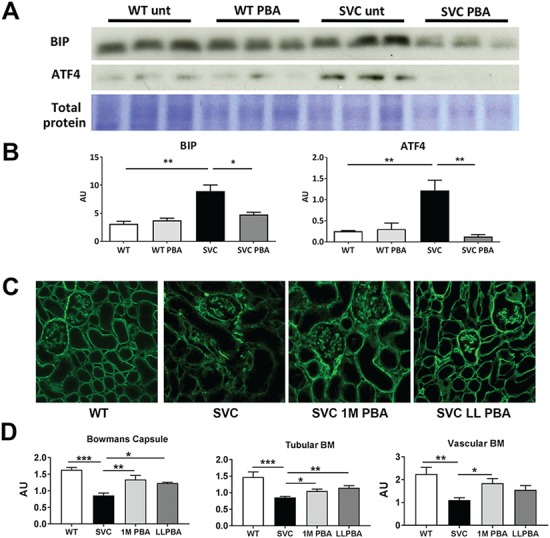
Chemical chaperone activity increases deposition of collagen IV in vivo. (A) Western blotting showed increased levels of Bip (∼2.9-fold increase) and ATF4 (∼4.6-fold increase) in untreated Col4a1+/Svc (SVC unt) which is reduced following PBA treatment. Representative band of total protein stain is given as loading control (the entire gel is provided in Supplementary Material, Fig. S9). (B) ImageJ densitometry analysis of Bip and ATF4 (n = 3). (C) Immunostaining against Col4a1 in PBA-treated and untreated Col4a1+/Svc mice (WT: wild-type; SVC: untreated; SVC 1M PBA: 1-month treatment; SVC LL PBA: lifelong chronic treatment from conception) on kidney sections revealed increased deposition of Col4a1 following PBA treatment. (n = 3–5 mice, Bowman’s capsule: SVC n = 30, SVC 1 M PBA n = 42, SVC LL PBA n = 16; Tubular BM SVC n = 89, SVC 1M PBA n = 77, SVC LL PBA n = 47; Vascular BM SVC n = 36, SVC 1M PBA n = 23, SVC LL PBA n = 15). (D) ImageJ analysis of fluorescence staining. (B), (D) One-way ANOVA post hoc Sidak test *P < 0.05, **P < 0.01, ***P < 0.001.